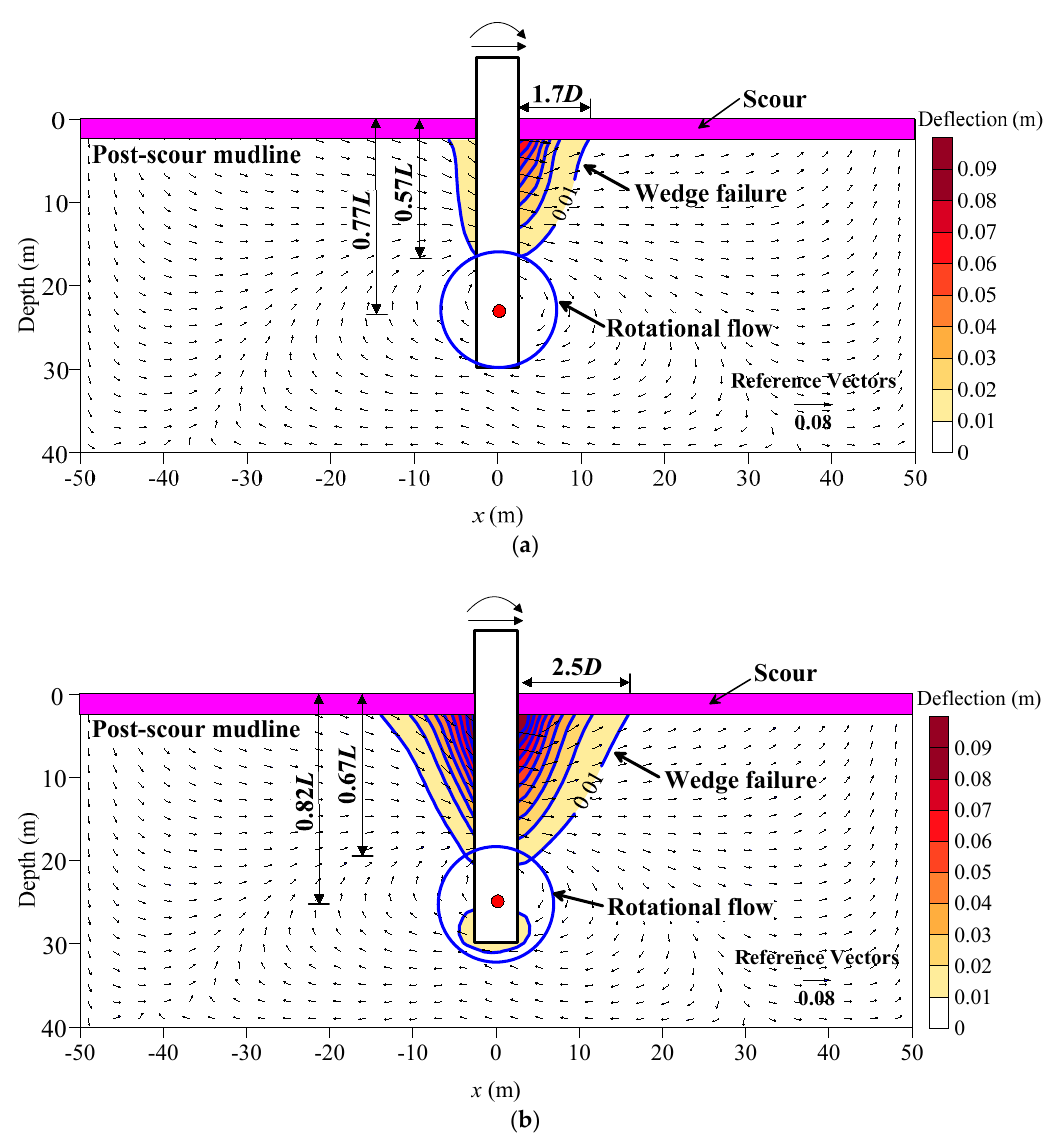
Figure 10. Computed soil displacement field and displacement vectors at the scour depth of S d = 0.5 D : ( a ) ignoring the stress history effect; ( b ) considering the stress history effect.